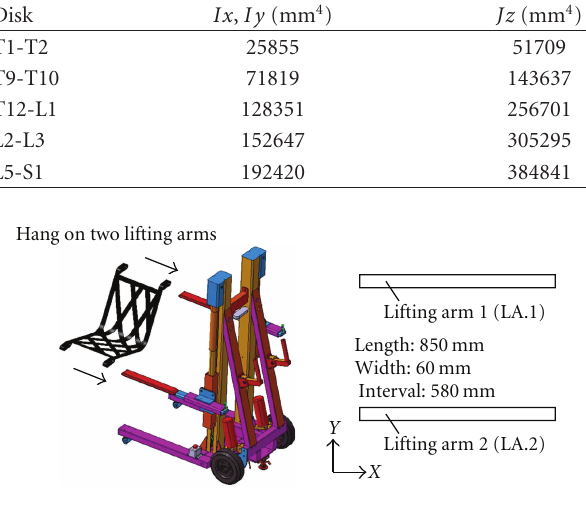
Figure 6: The initial model of the lifting arms.